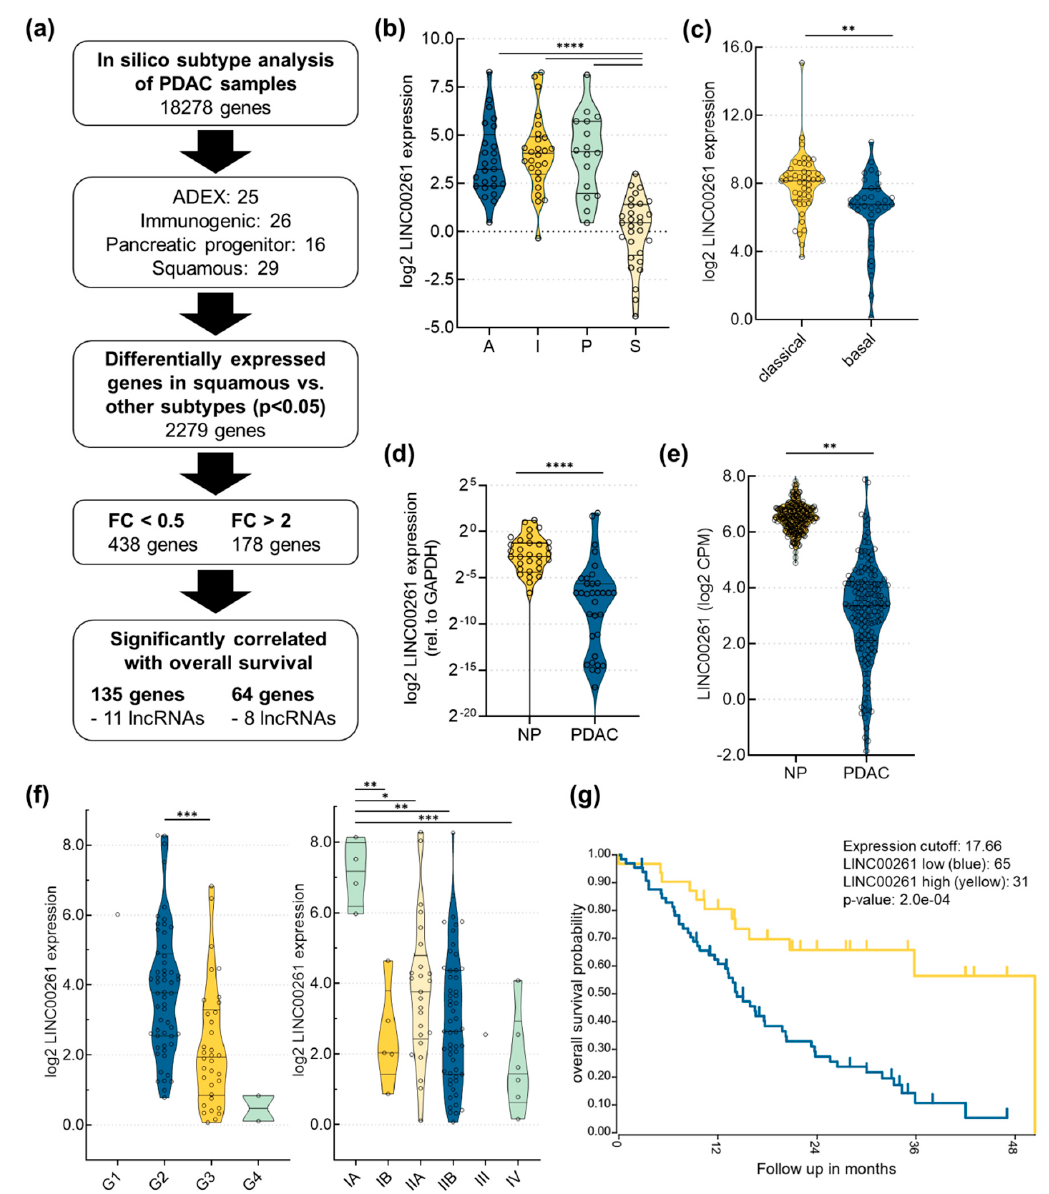
Figure 1. Analysis of long intergenic non-coding RNA 261 (LINC00261) expression in pancreatic adenocarcinoma (PDAC). ( a ) Flow chart that outlines the identification of candidate long non-coding